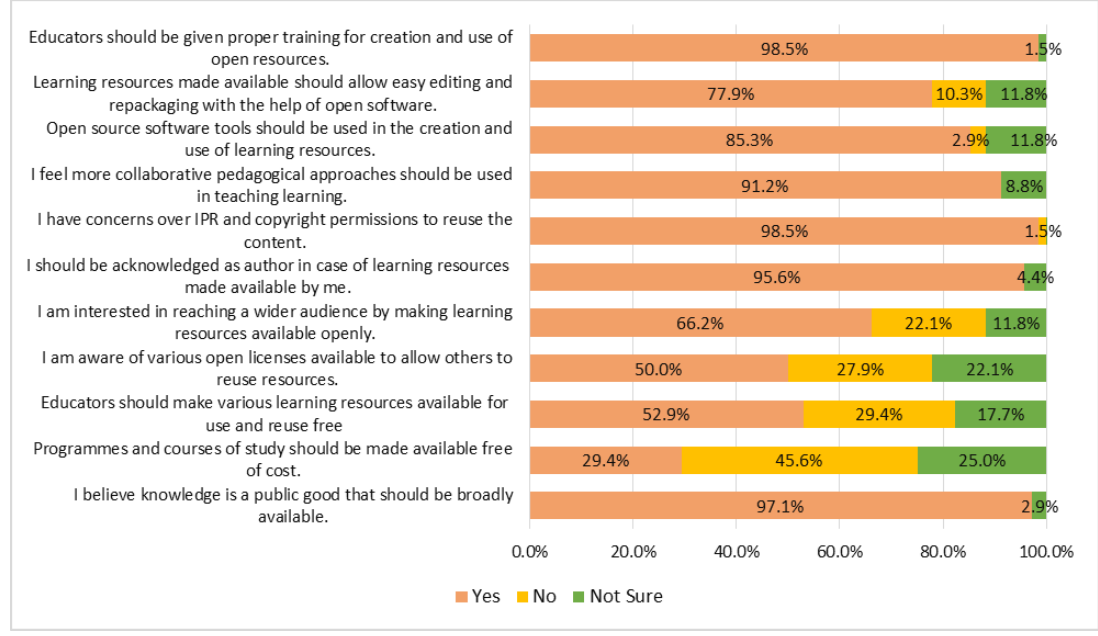
Figure 1. Perceptions towards